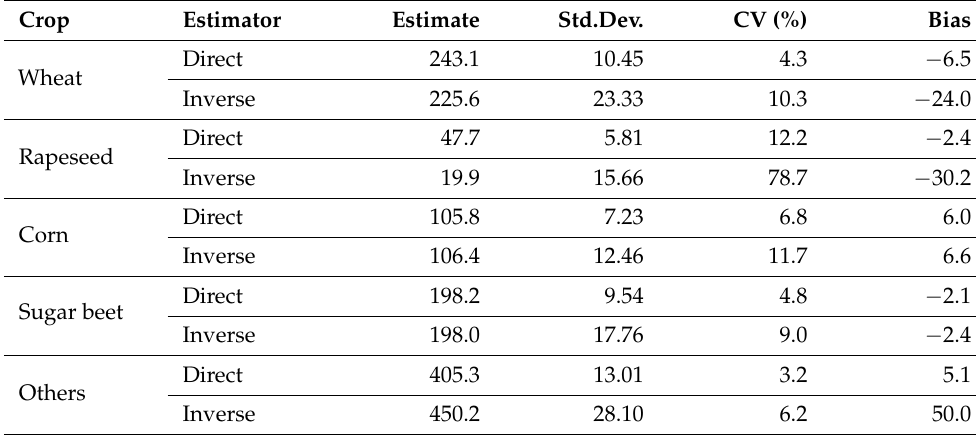
Table A1. Statistical performances per crop for the Bivariate